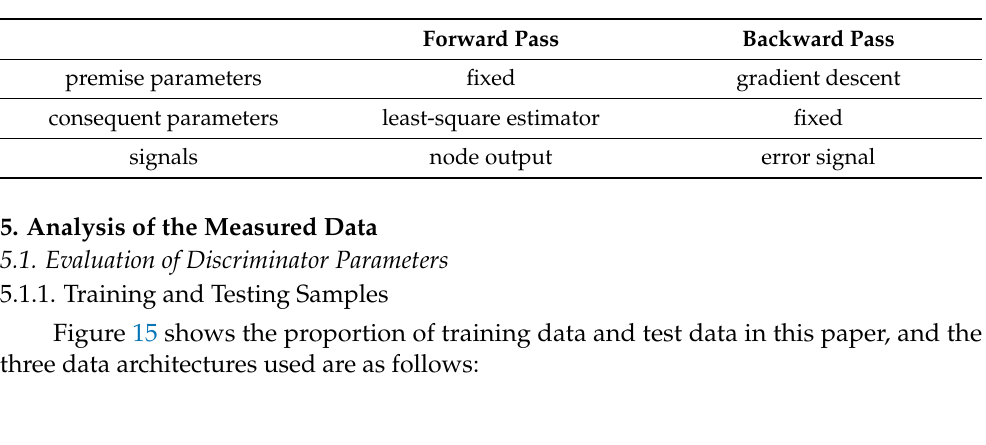
Table 4. The compound learning program